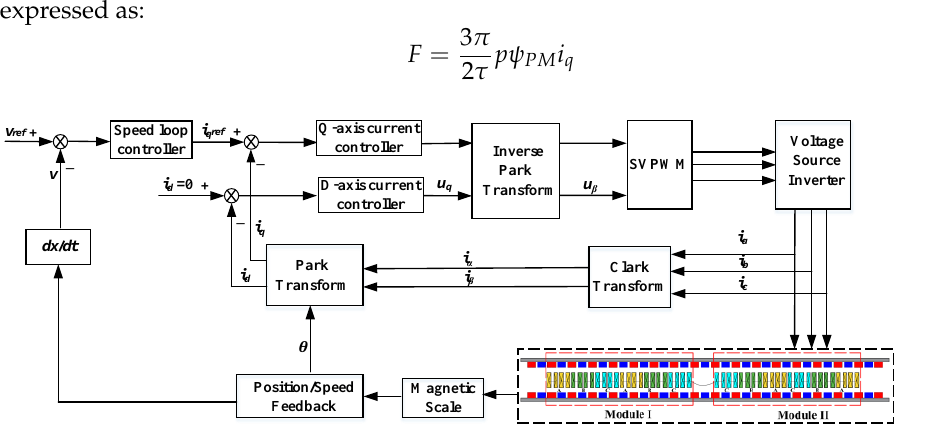
Figure 3. Control diagrams of the two-module PMLSM.